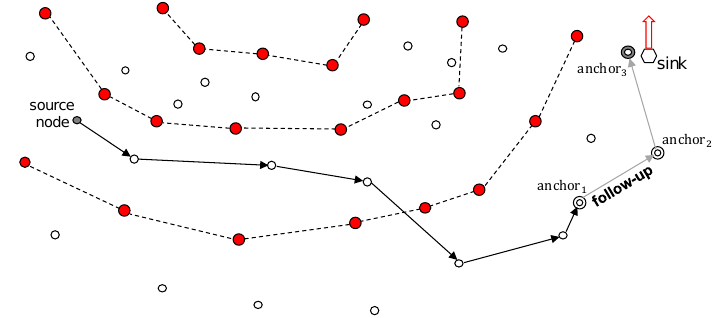
Figure 10. Follow-up mechanism.